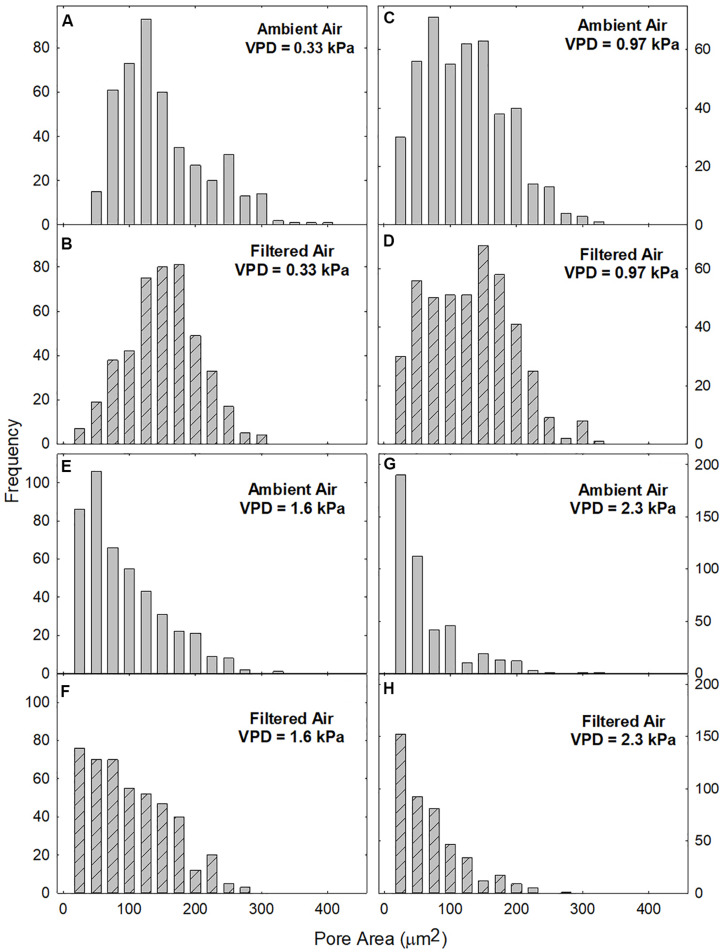
Frequency distribution of pore areas (A) at different levels of evaporative demand (VPD), in leaves exposed to ambient (gray bars; A,C,E,G) or filtered (hatched bars; B,D,F,H) air. Area classes: 0 ≤ A < 50 to 400 ≤ A < 450, centered at 25–425. The smallest visible bars represent 1 pore.